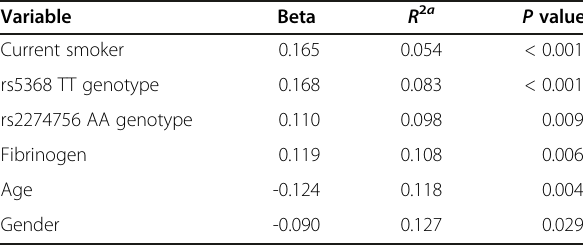
Table 4 MMP9 levels: stepwise linear regression analysis, including genotype